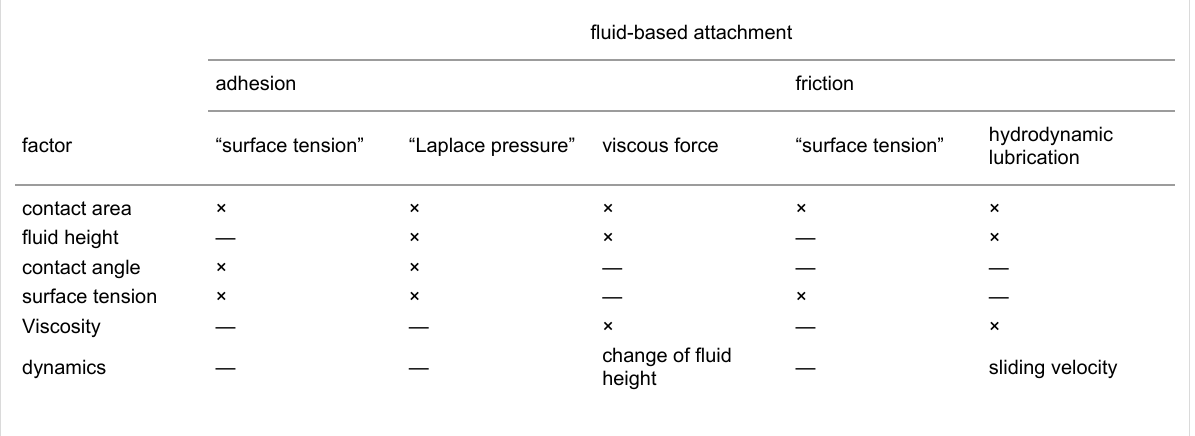
Table 1: Summary of physical principles often used to model the attachment forces generated by the adhesive feet of insects. However, based on this simple model (besides other limitations discussed in detail in the text), insects should not be able to generate sufficient static friction forces to prevent